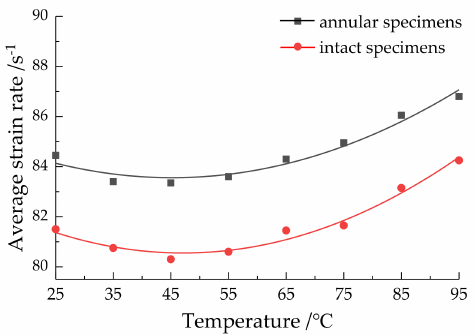
Figure 10. Relationship between average strain rate and water